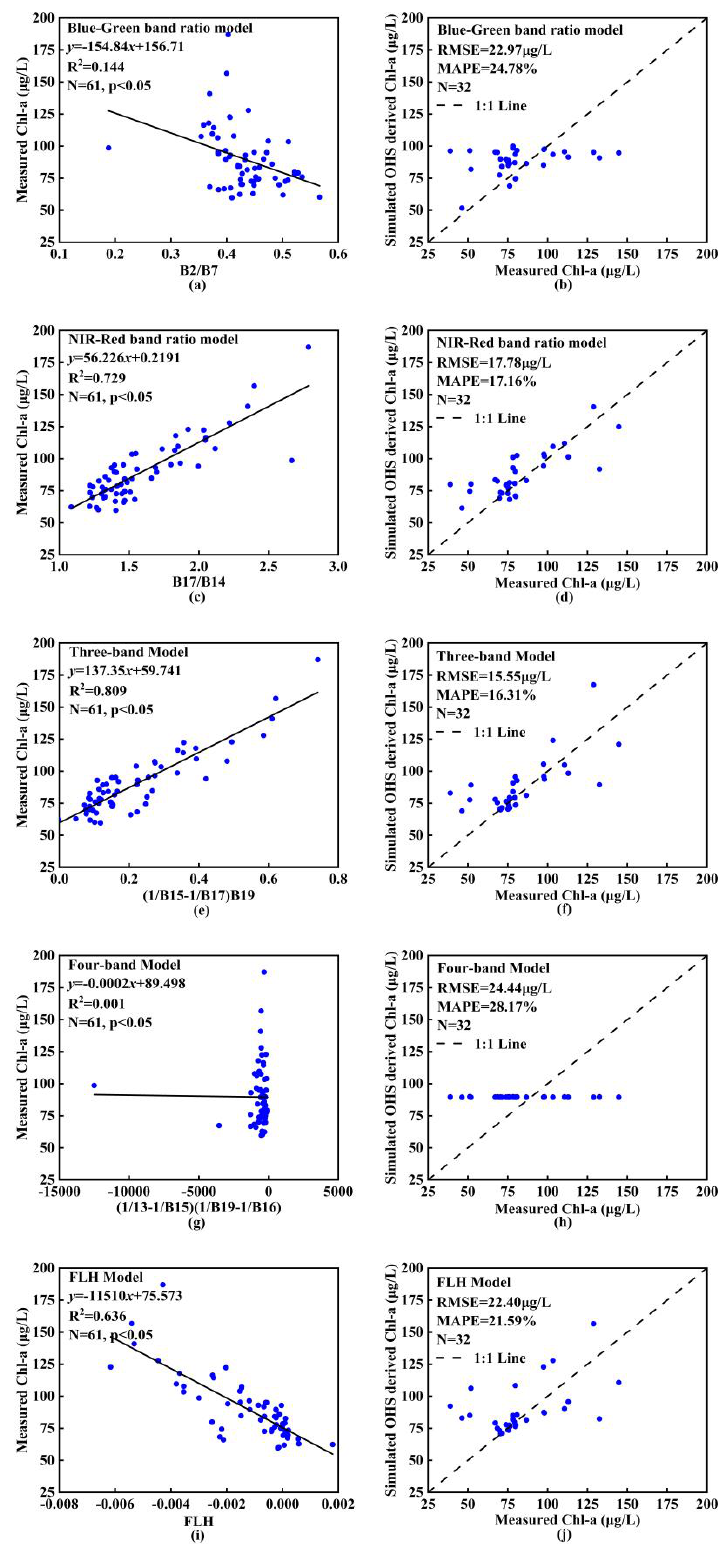
Figure 3. Scatter-plots of Chl-a model development ( a – i ) between measured in situ Chl-a data and simulated OHS-based derived R rs , and Chl-a model validation ( b – j ) between measured and simulated OHS-based derived Chl-a through Equations (10)–(15). Chl-a is chlorophyll-a concentration and OHS is OHS imagery.